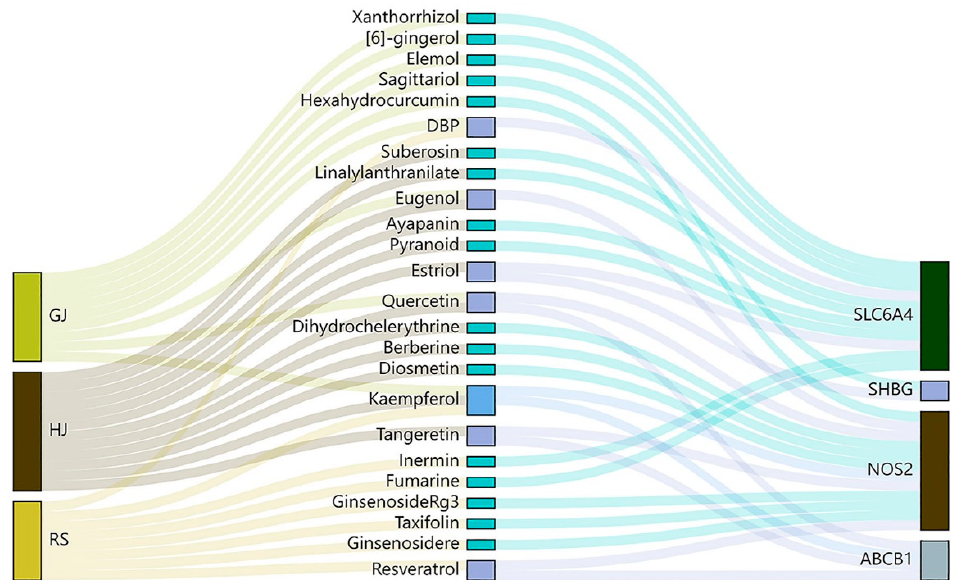
Figure 10. Alluvial plots of herb-component-target network.